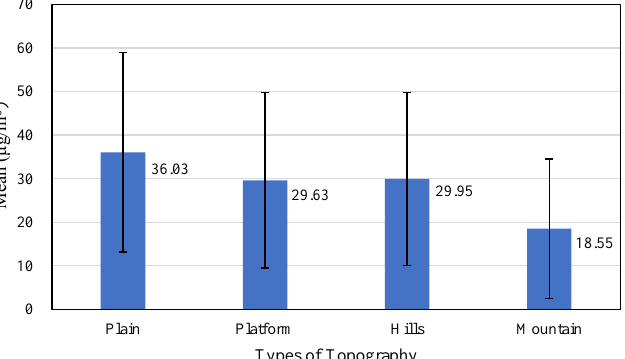
Figure 4. Comparisons among the average PM 2.5 concentrations during 2000–2019 for different topography types.